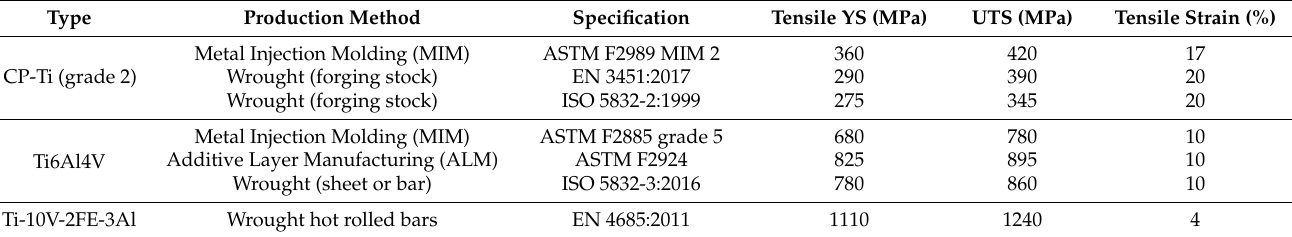
Table 1. Tensile properties of Cp-Ti and Ti